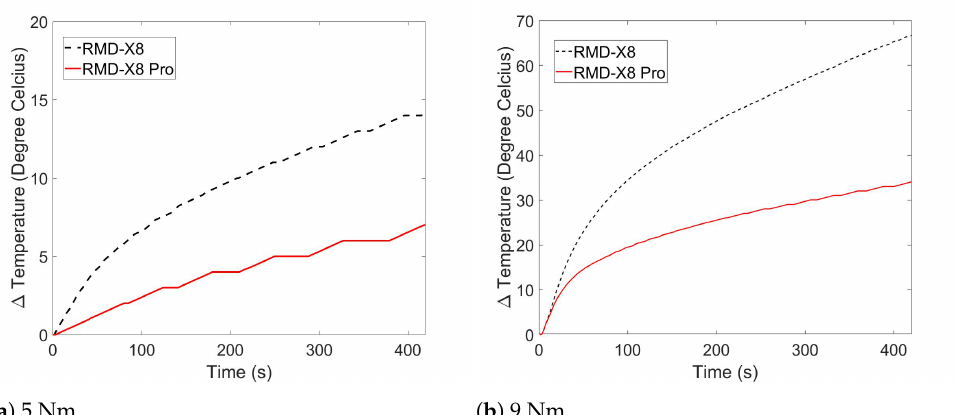
Figure 5. Internal temperature over time for X8 and X8 Pro